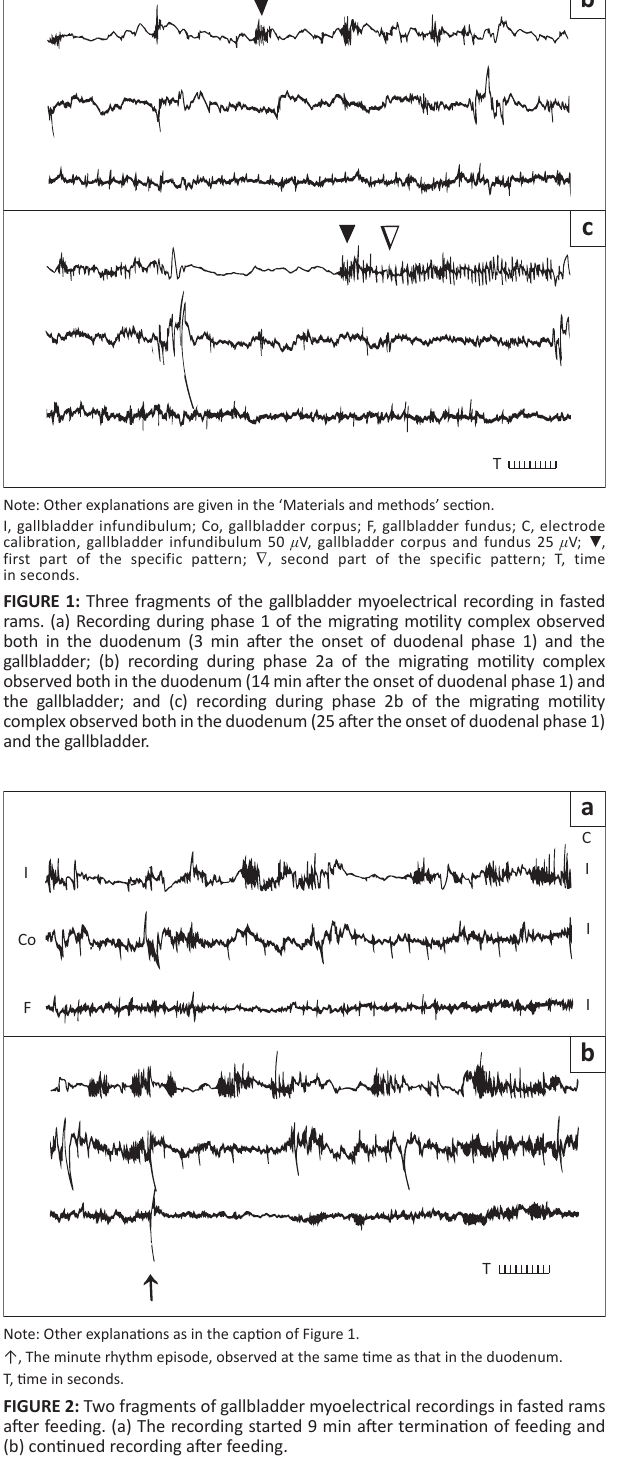
FIGURE 2: Two fragments of gallbladder myoelectrical recordings in fasted rams after feeding. (a) The recording started 9 min after termination of feeding and (b) continued recording after